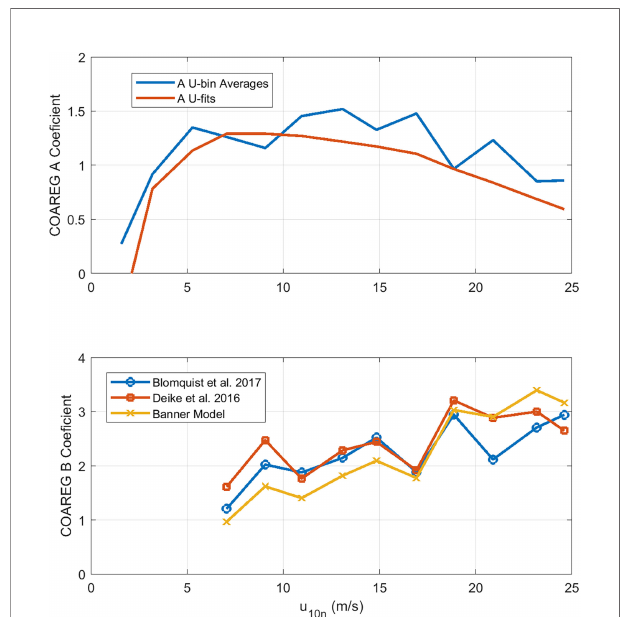
FIGURE 6 | Retrieved values of COAREG constants, A (upper panel) and B (lower panel), as a function of wind speed. For A , retrievals are based on mean values of observed k w 660 averaged in wind speed bins plus values of k w 660 computed from wind-speed power law fi ts. For B , only the wind speed bin results are shown. There are curves for three possible choices of f wh . Data for U 10 n < 6 are not shown because no whitecaps were